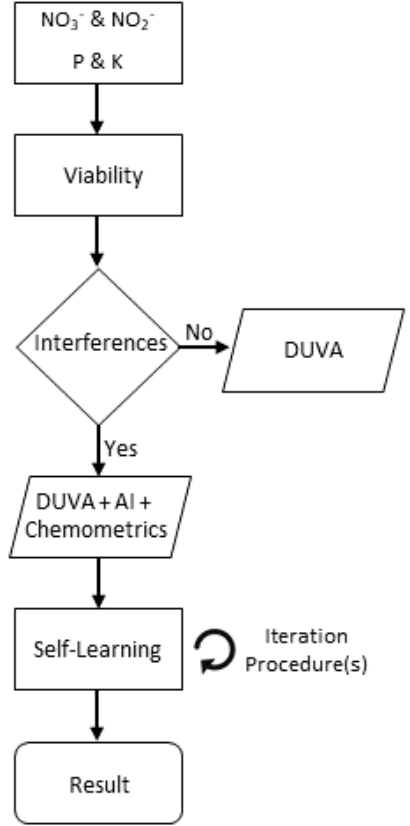
Figure 2. Workflow planned procedures for nitrate and nitrite assessment and existing interferences.